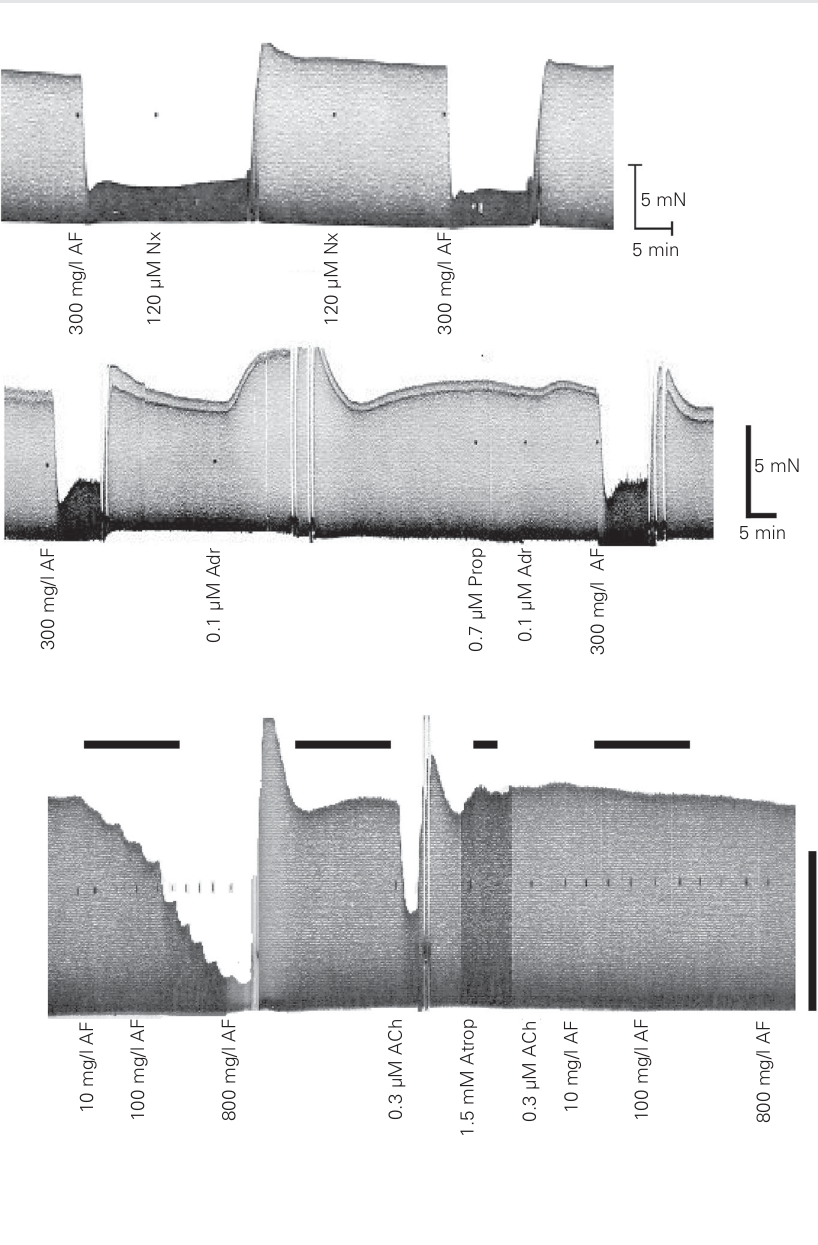
Figure 6. Nayler and Merrillees (26) protocol used to study the cellular inward calcium cur- rent in the guinea pig atrium. Control solution (left panel): the positive staircase (Bowditch phenomenon is seen at 60 bpm) increased the atrial force over its initial value, but in the presence of the acetic acid extract of Psidium guajava (0.25 g/l), in spite of the small posi- tive staircase (60 bpm), the force overshoot did not occur and the final force only reached the initial control level. Similar results were obtained with 4 other preparations (8 trials, 27 ± 0.1 (cid:1)